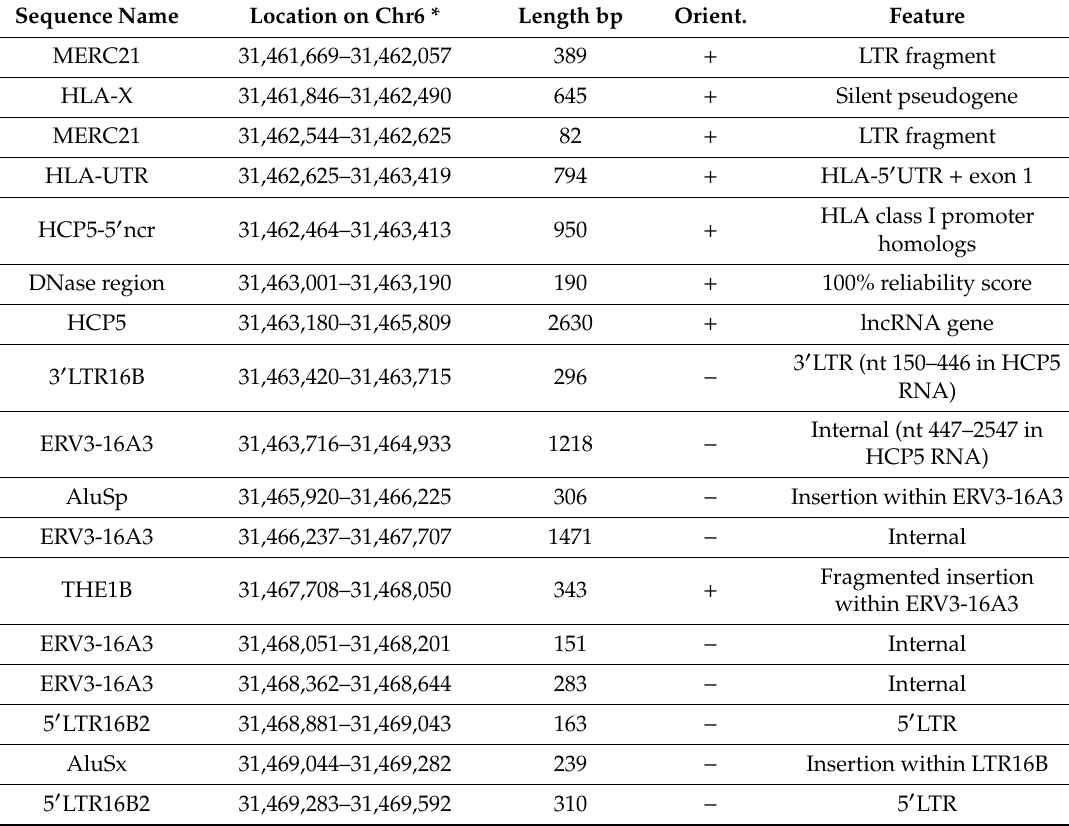
Table 1. The chromosomal location of HCP5 and the ERV16 ( LTR16B and ERV3-16A3 ) retroelement between the pseudogene HLA-X and the HCG26 lncRNA gene within the HLA class I region